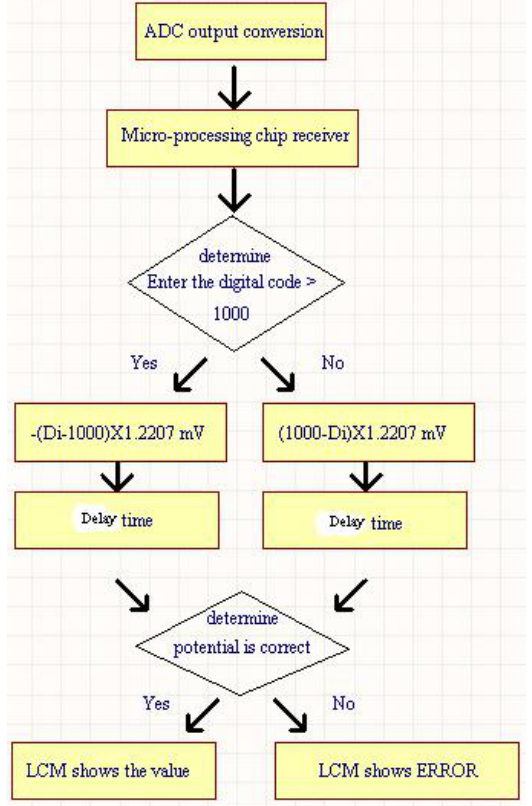
Figure 7. The internal operation of P89C51 for urea